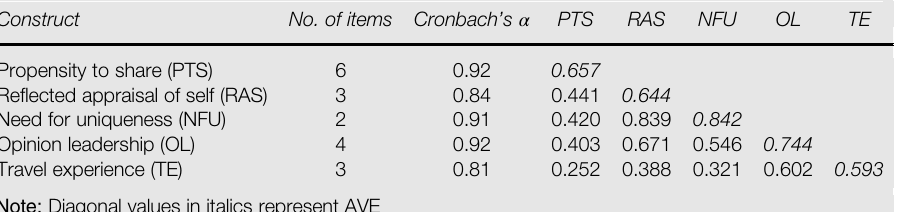
Table I Correlation matrix (CFA results) Construct No. of items Cronbach ’ s α Propensity to share (PTS)